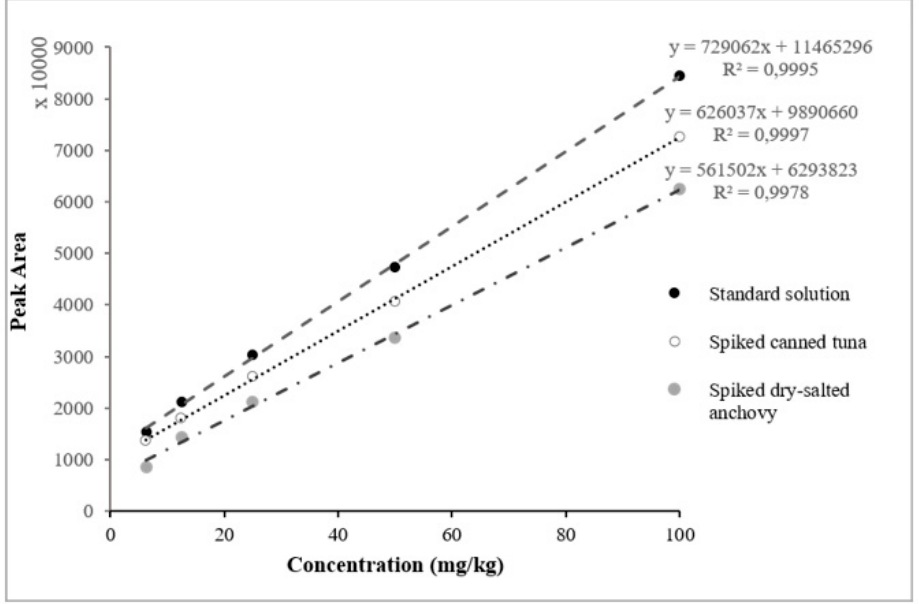
Figure 2. Calibration curves of histamine in solution, in canned tuna, and in dry-salted anchovy.